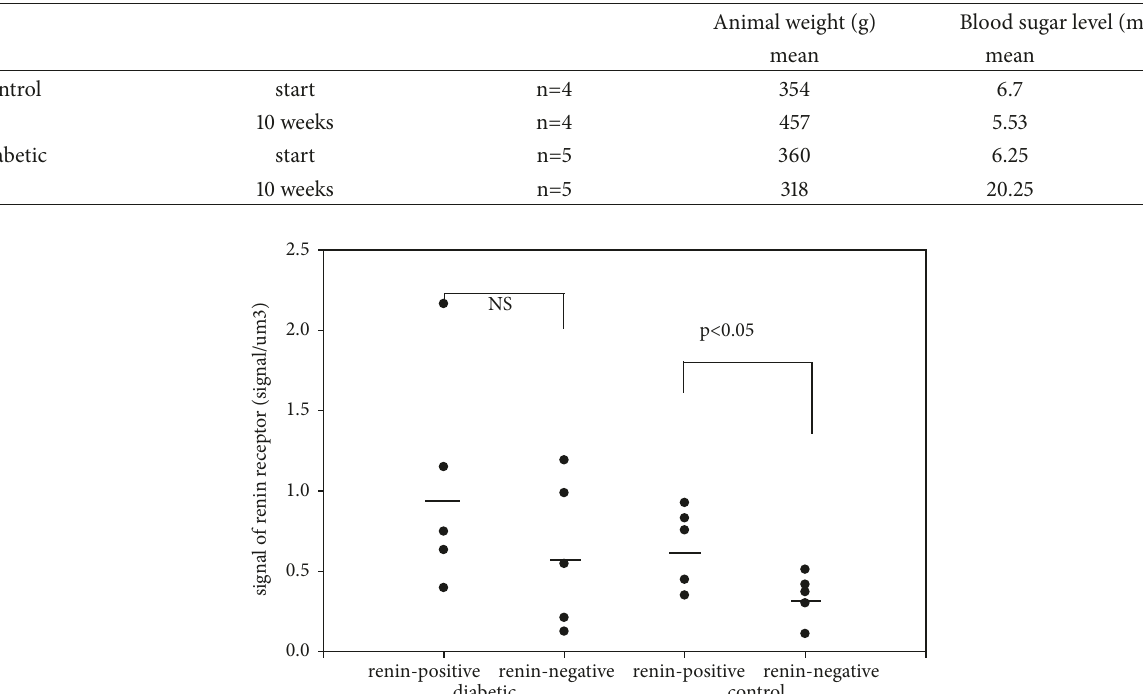
Table 1: Changes in blood sugar level and body weight following the STZ diabetic protocol.